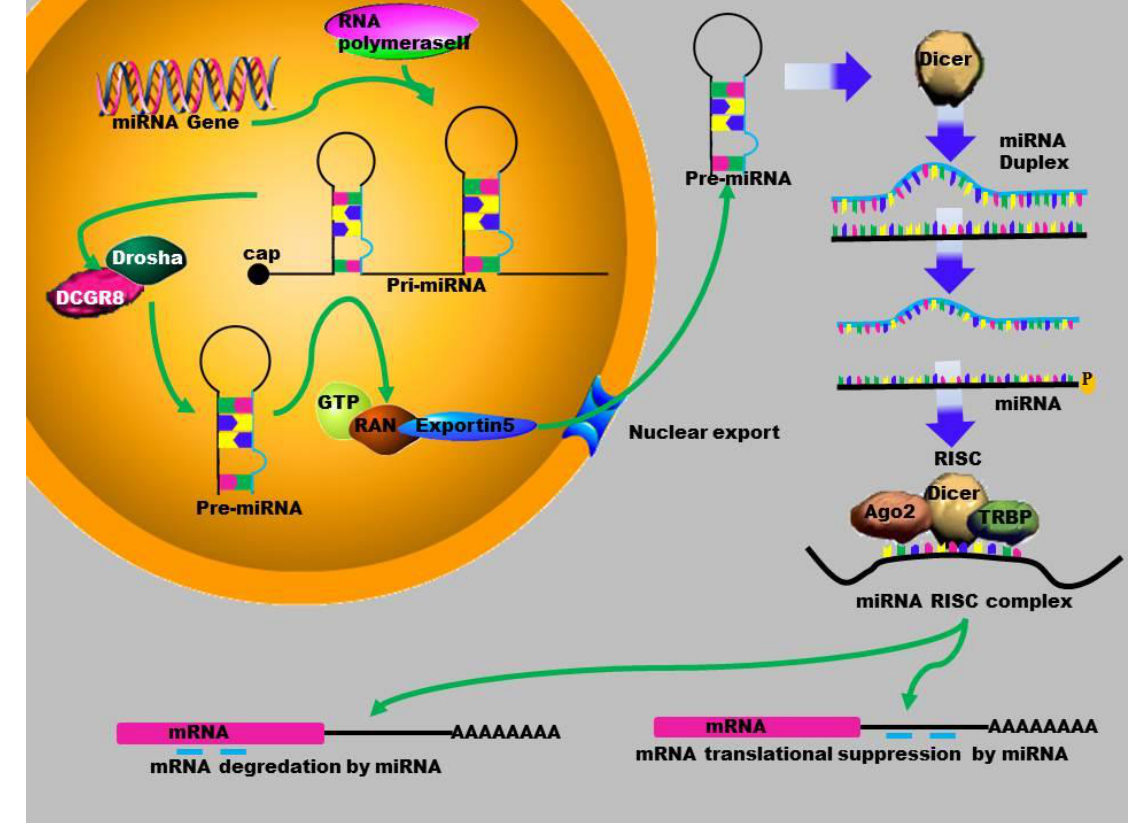
Figure 1. Schematic outline of the biogenesis of miRNA: MiRNA is transcribed by RNA polymerase II to form a primary microRNA molecule. These Pri-mRNA molecules are large RNA precursors and are comprised of a 5ʹ-cap and poly-A tail. This is then cleaved by the Drosha complex to generate pre-miRNA that is exported to the cytoplasm by Exportin-5, where it is processed by Dicer into a miRNA duplex. The guide strand (mature miRNA) is then incorporated into the miRISC where gene silencing can be accomplished via mRNA target cleavage (degradation), or through the prevention of